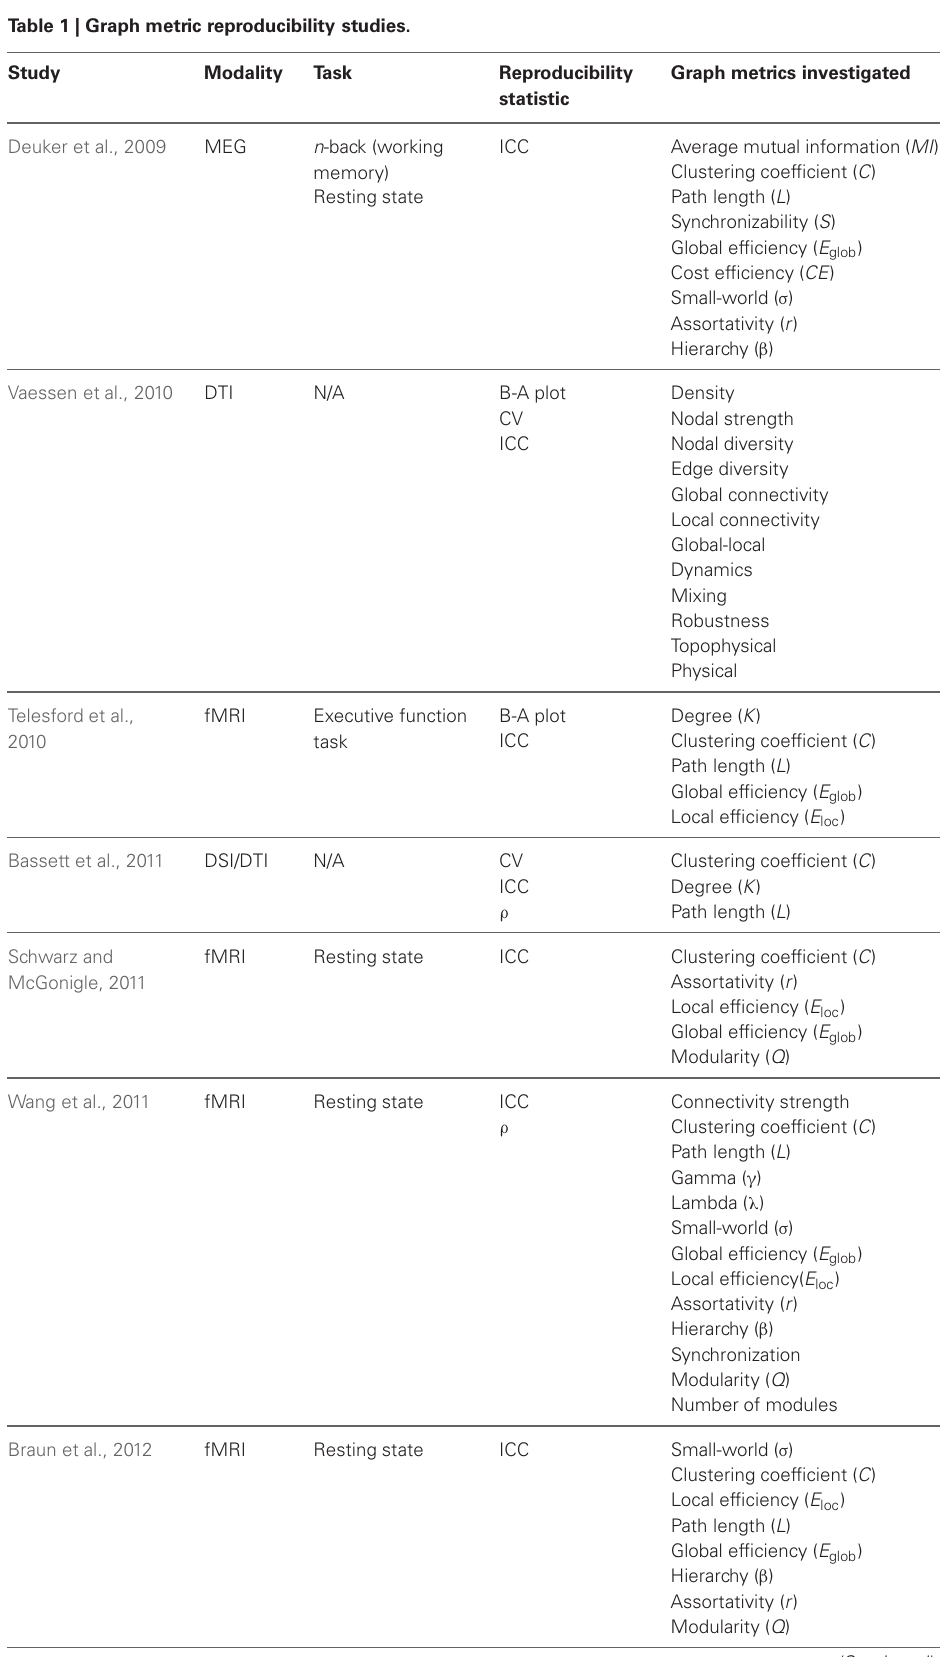
Table 1 | Graph metric reproducibility